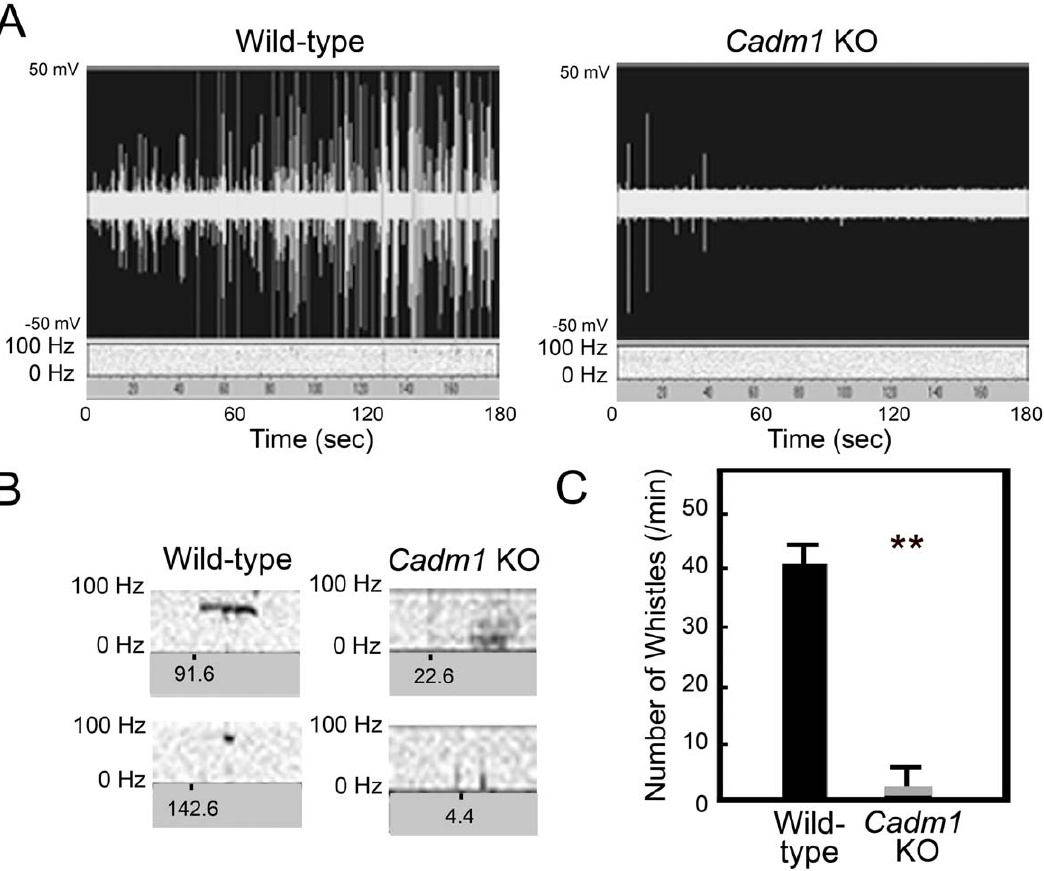
Figure 2. Analysis of ultrasonic vocalizations (USVs) of Cadm1 KO mice (P8). (A) Real-time spectrography of the USVs by pups after separation from the dam. (B) Major vocalization patterns of Cadm1 KO and wild-type pups. Wild-type vocalization was mainly whistle-type USVs, but Cadm1 KO mice exhibited only a small number of click-type vocalizations. (C) The number of whistle-type USVs per min by pups. Vocalizations were recorded for 3 min. Experiments were done three times for 5 pups in each group, and an example of typical results is shown. Values are mean 6 standard error (SEM). Student’s t -test (** p , 0.01).